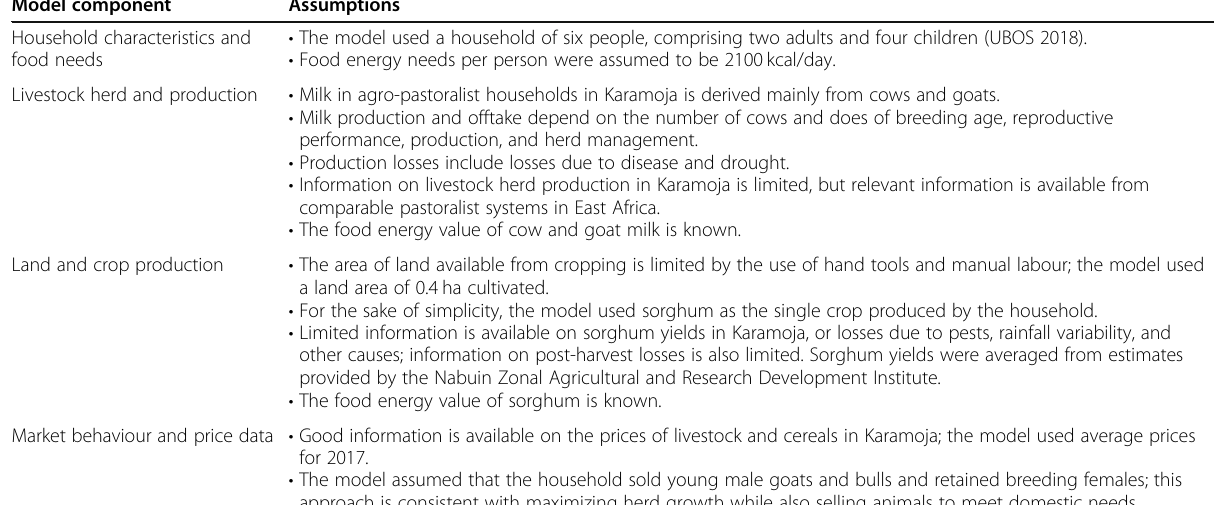
Table 1 Model components and assumptions Model component